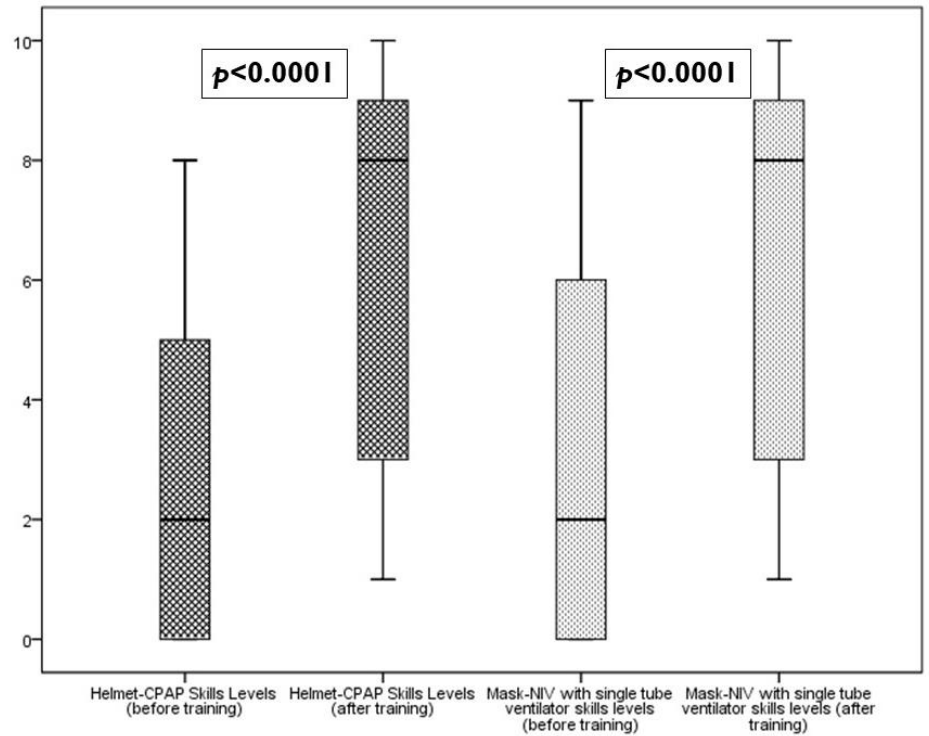
Figure 1. Comparison of Helmet-CPAP and NIV skill levels before and after the training (total sample—59 nurses).